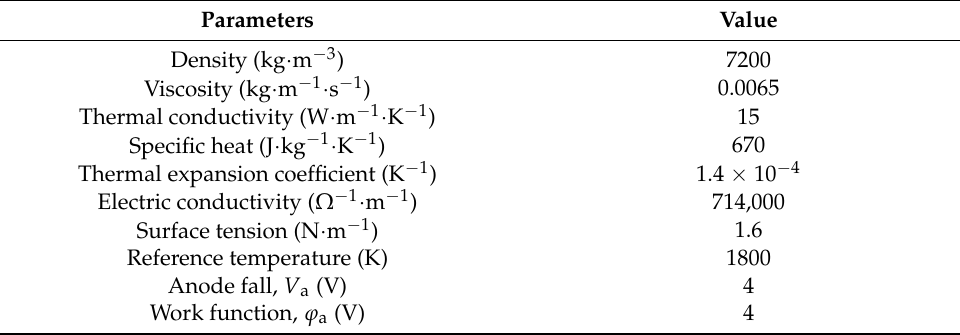
Table 2. Thermophysical properties of the molten